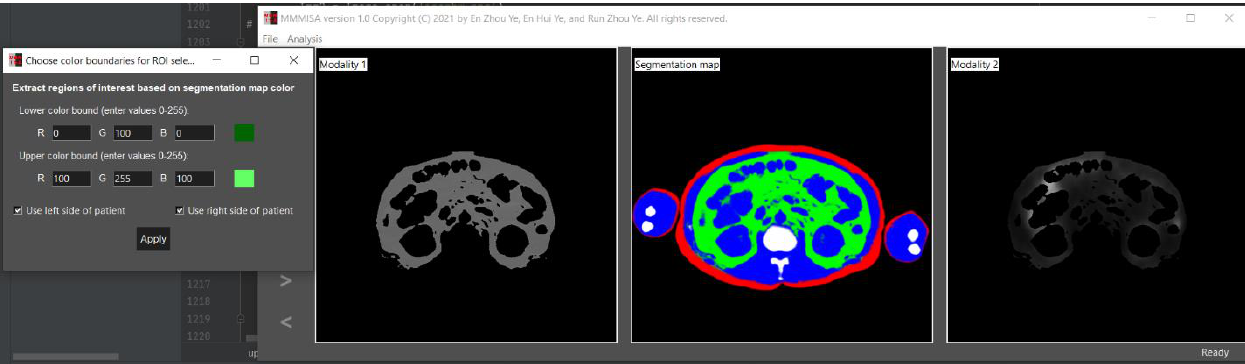
Figure 2. ROI selection window and main window with updated modality 1 and 2